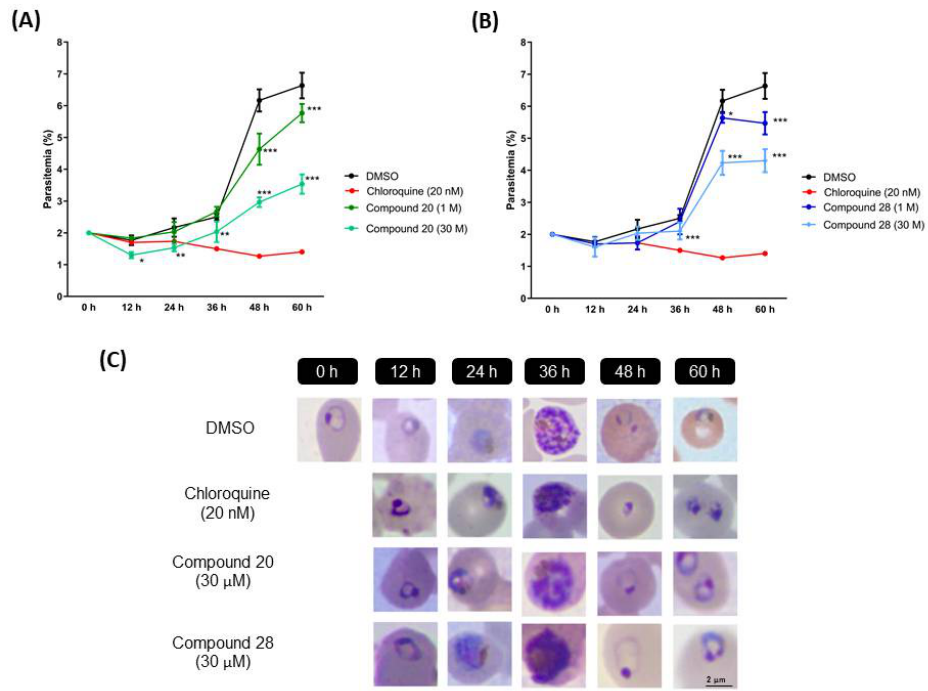
Figure 5. Parasitemia reduction with compound 20 ( A ) and compound 28 ( B ) to determine the stage activity. Data are means ± SD. Ring-stage synchronized parasites with sorbitol 5% were treated with chloroquine (20 nM), compound 20 (30 µM), and compound 28 (30 µM). The chosen treatment concentration was the IC 50 values obtained for these compounds against the 3D7 parasites. ( C ) After drug administration, smears of P. falciparum 3D7 strain were taken at 0, 12, 24, 36, 48, and 60 h after drug administration, observing the growth development of treated parasites. * p ≤ 0.05, ** p ≤ 0.01, *** p ≤ 0.001.